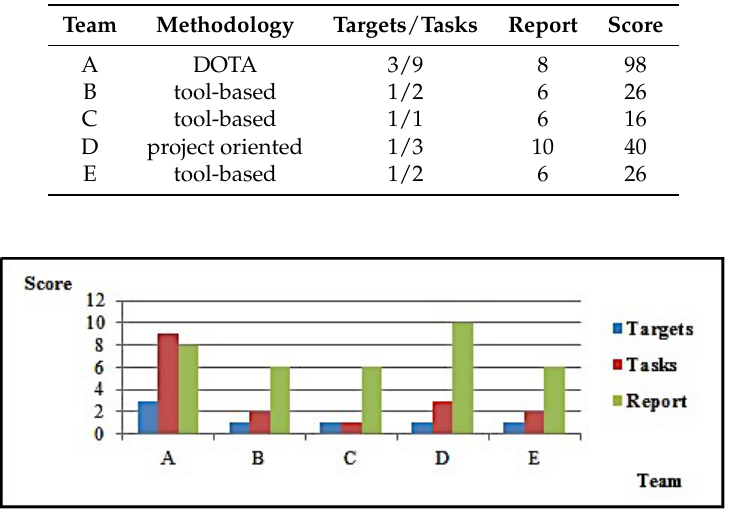
Figure 8. Comparative split scores–Targets, tasks, and report, organized by team.